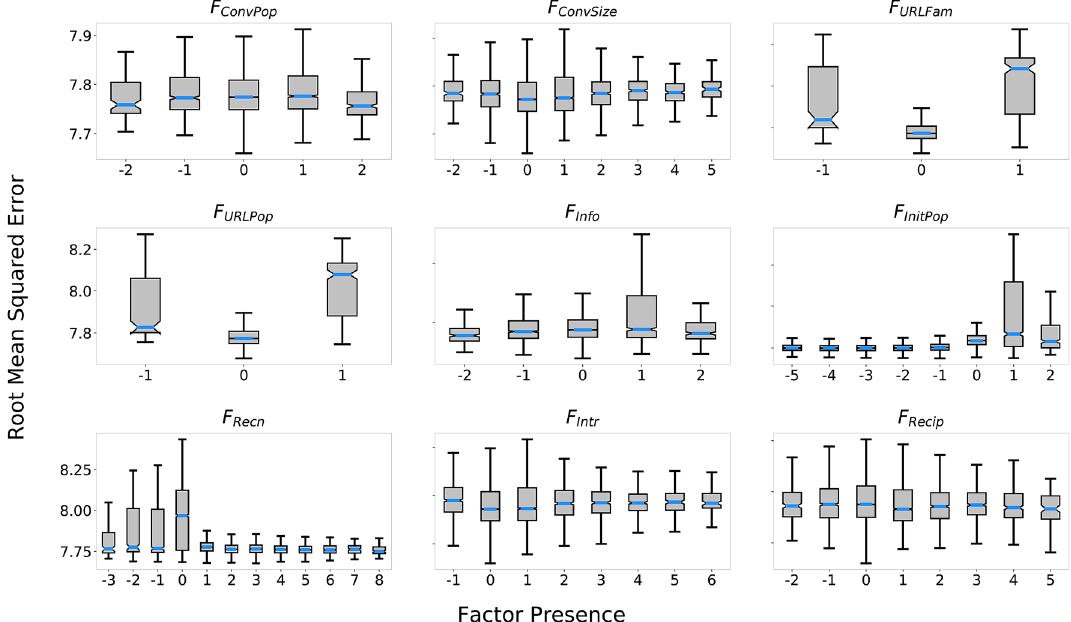
Figure 3. Marginal RMSE of responsiveness by factor presence of simulations of the models generated through the genetic program. F Recn shows significantly lower RMSE when positively present in u ( m ) and F InitPop shows significantly lower RMSE when negatively present in u ( m ). Both content URL related factors, F URLPop and F URLFam show significantly lower RMSE when absent from u ( m ). In order to reduce statistical bias, only factor presence values that appeared at least 100 times in the genetic program individuals are